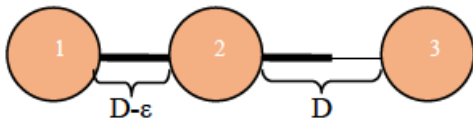
Figure 3: The lengths and